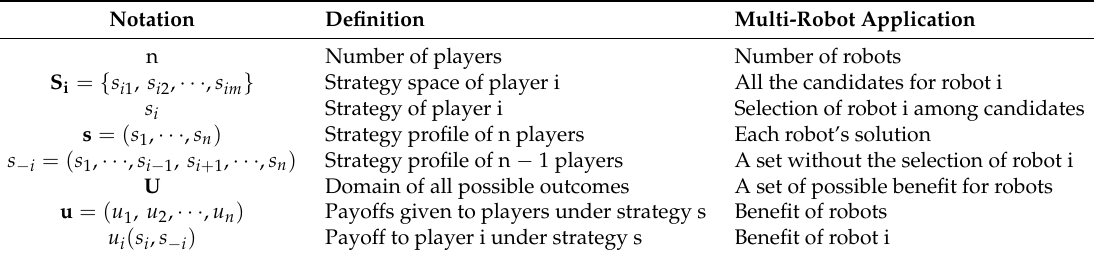
Table 3. Game theory terminology in multi-robot